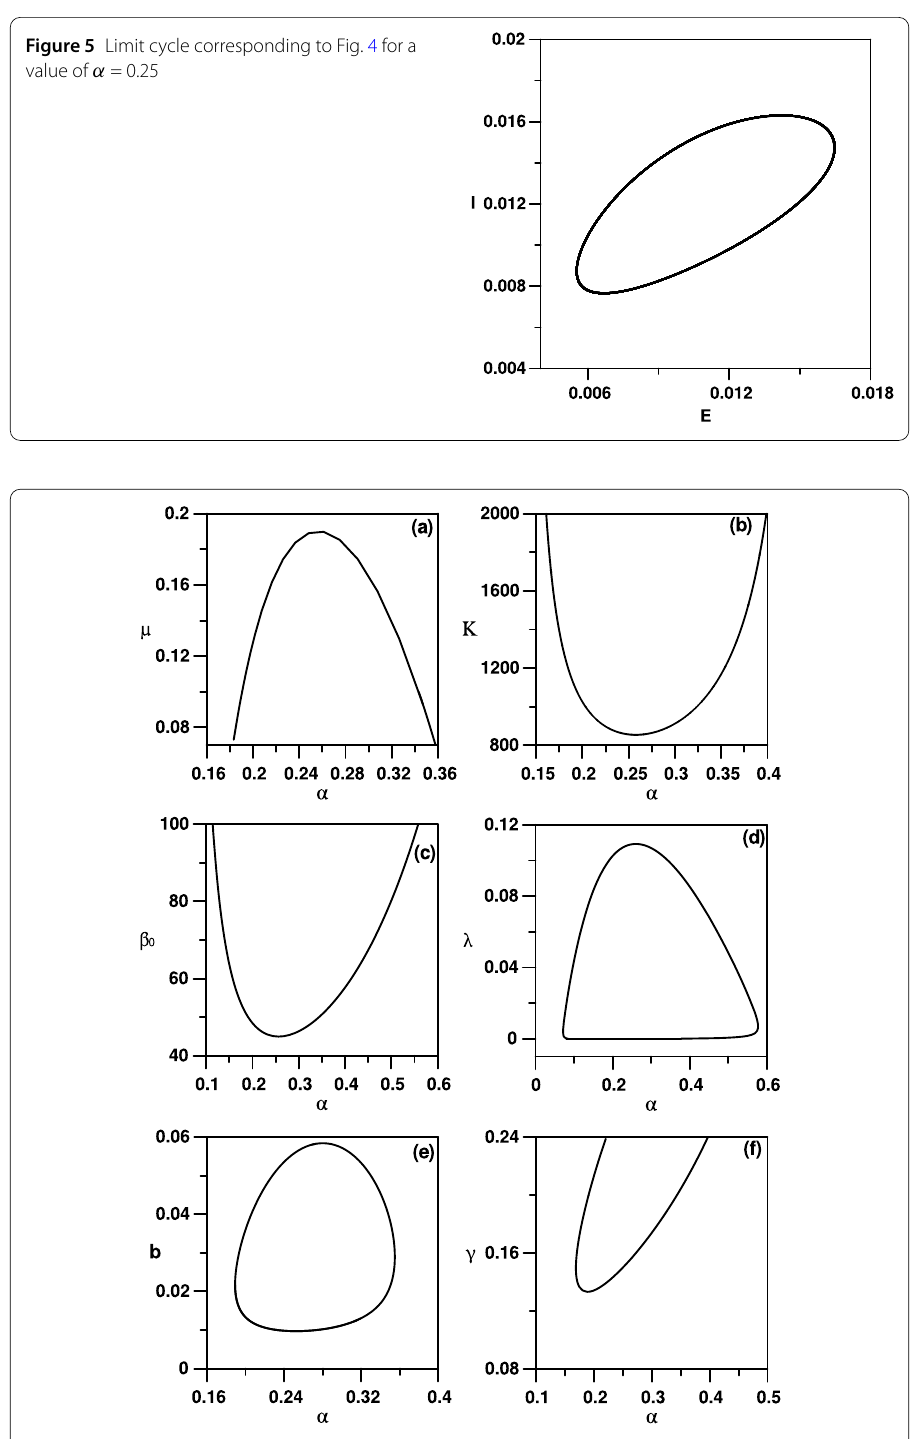
Figure 6 Two parameter continuity diagrams showing the locus of Hopf point of Fig. 4